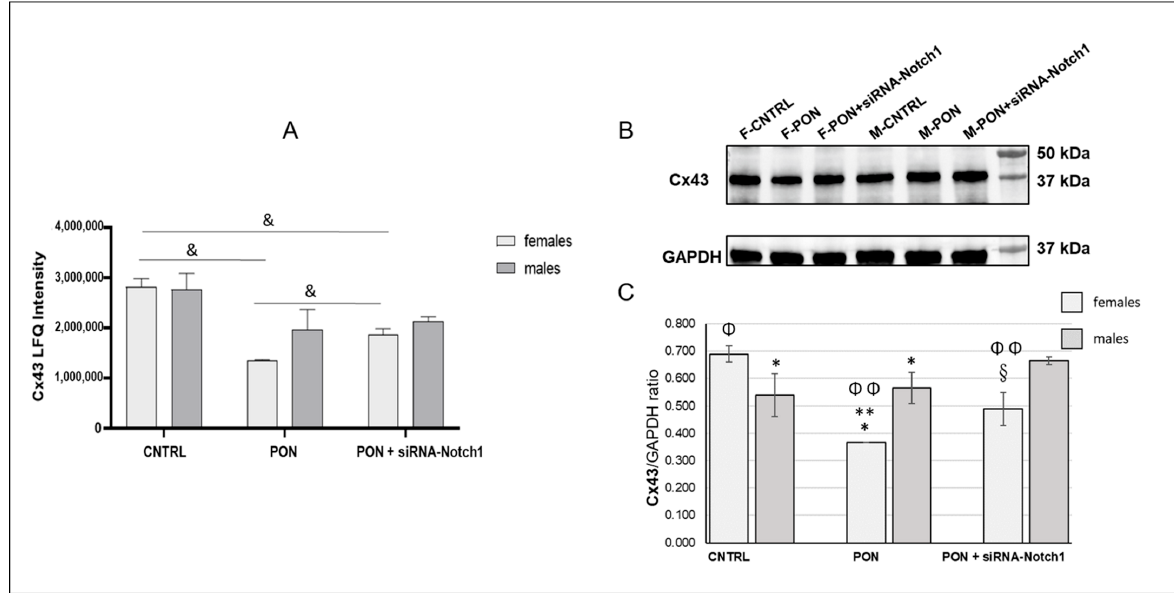
Figure 1. Heart Cx43 protein modulation. ( A ) Differential Proteomics Analysis demonstrated the downregulation of Cx43 only in female ponatinib-treated mice compared to control and siRNA-Notch1 ones. Histogram representing the proteomics data related to Cx43 abundance in heart mice samples. Data were reported as mean ± standard deviation of LFQ Intensity parameter analytical replicates ( n = 3). &: p < 0.05 at ANOVA test and validated with post hoc-Tukey’s HSD test. Proteomics data were confirmed by Western Blot analysis as shown in Panel ( B ) of the figure. This shows a representative blot of one group of the three groups analysed. ( C ) Histogram representing the Cx43 protein expression in heart mice samples. Data are expressed as mean ± standard deviation, n = 3. ** p < 0.001 vs. CNTRL; * p < 0.05 vs. PON + siRNA-Notch1; § : p < 0.01 vs. CNTRL; Φ : p < 0.05 vs. males; Φ Φ : p < 0.01 vs.